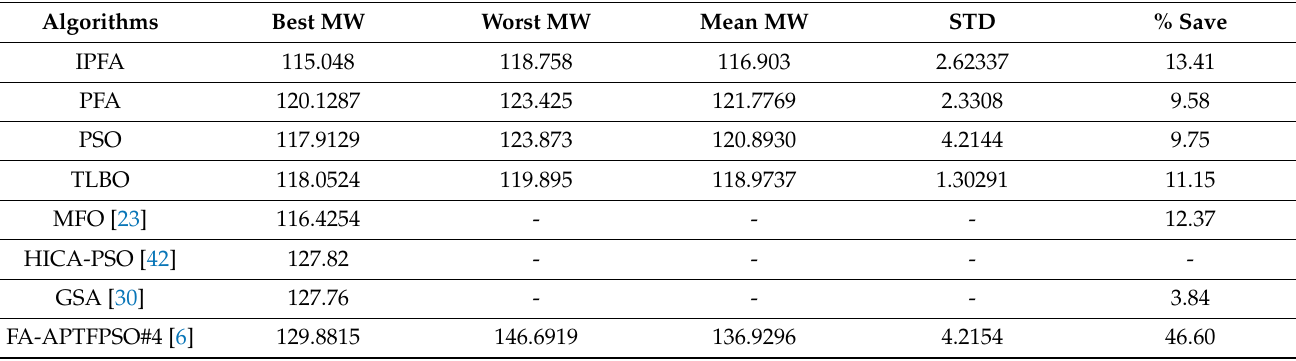
Figure 5. A schematic diagram of the IEEE 118 bus system, reproduced with permission from [43], John Wiley and Sons, 2018. Table 5. Comparison with other